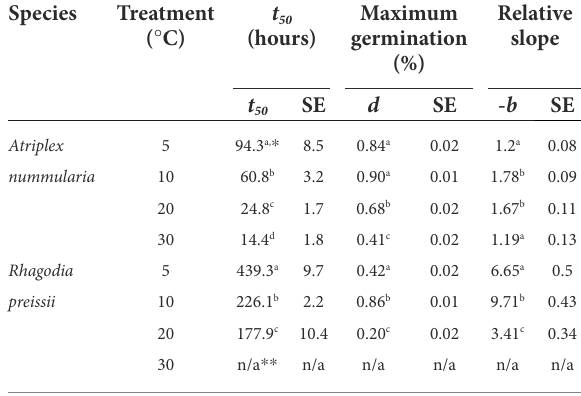
TABLE 2 Temperature experiment 1A: influence of temperature on seed germination of A. nummularia and R. preissii under four constant temperatures, expressed by the estimated parameters and their associated standard errors (SE) from the log-logistic model (1) applied to the data * .